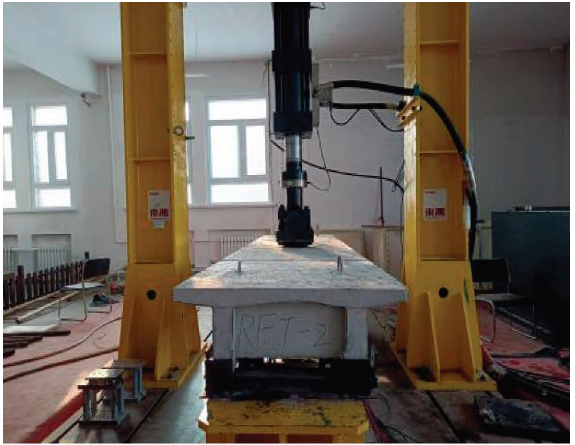
Figure 2: PLS-500 test system.